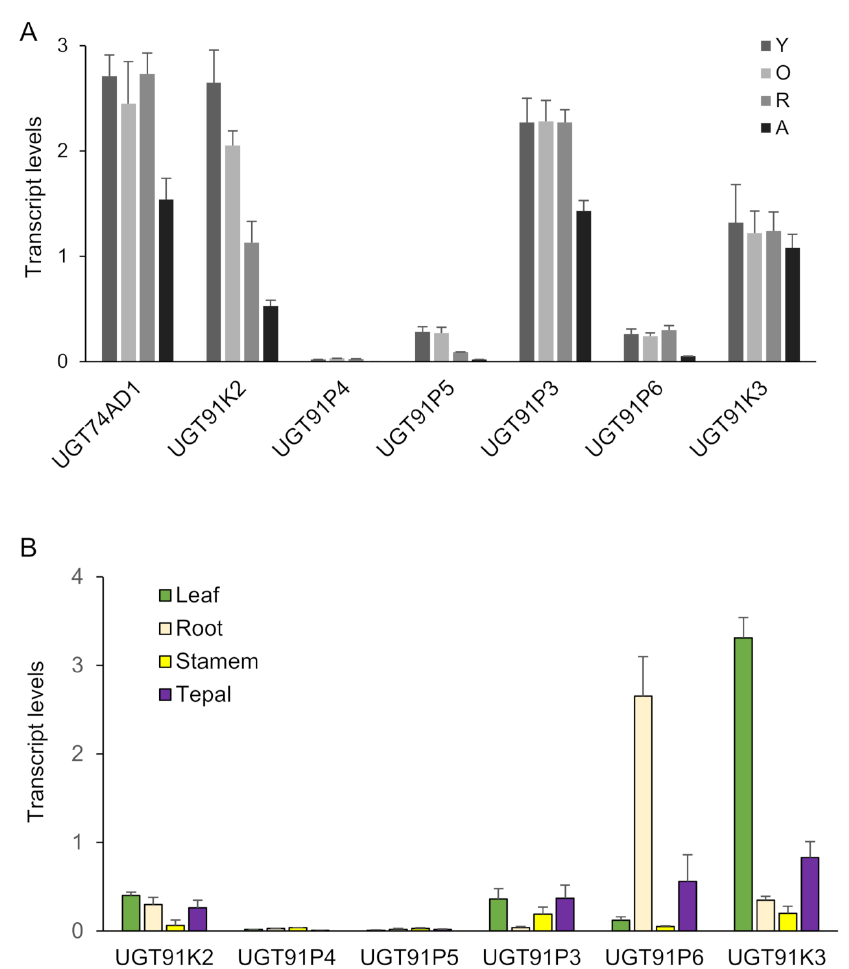
Figure 2. Transcript abundance of saffron genes encoding for putative UGTs. Transcript abundance was determined by qRT-PCR. ( A ) Expression levels in stigma tissue. RNA was isolated from stigmas at four different developmental stages: A (yellow stigma), O (orange stigma), R (red undeveloped stigma), A (stigma at anthesis). ( B ) Expression levels in different vegetative tissues. Means and standard errors are shown ( n =